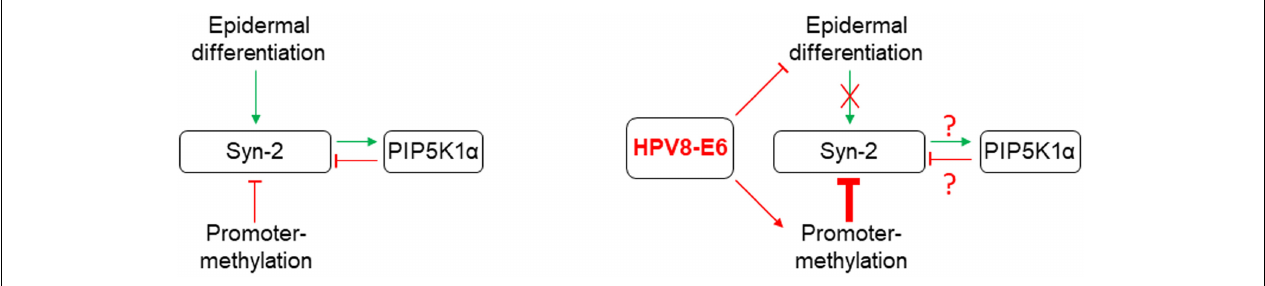
FIGURE 5 | Graphical summary of the regulatory pathways identified in this study controlling Syntenin-2 expression in normal keratinocytes (Left). Known HPV8-E6 mediated interference with these mechanisms is shown on the